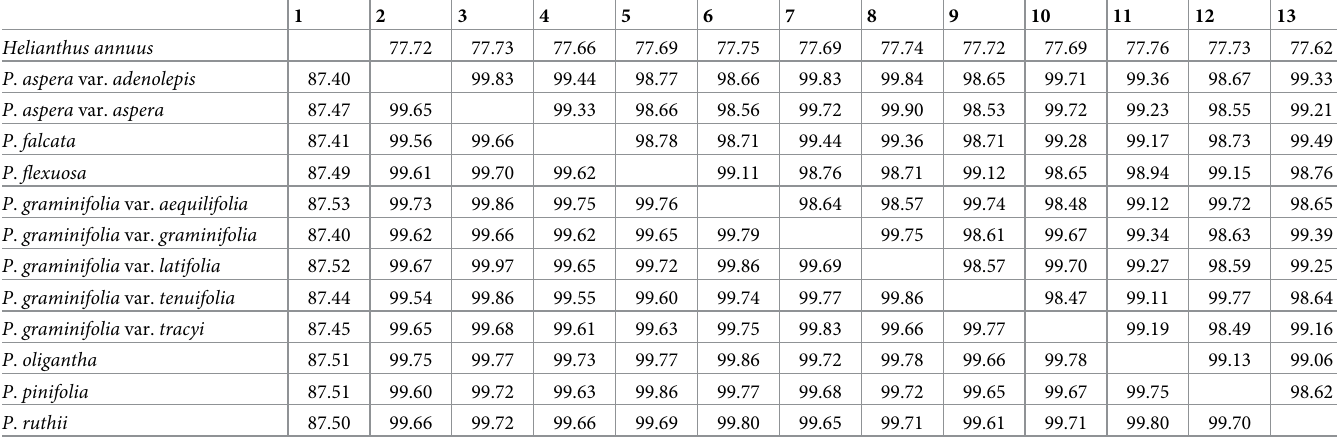
We reconstructed two maximum likelihood (ML) phylogenies, one with cp genomes (Fig 2) and one using the nuclear ribosomal repeat region (Fig 3). Only branches with 50% bootstrap (BS) support or higher were included in the topology. The cp genome and nuclear ribosomal region ML phylogenies differ primarily in the placement of some varieties of P . graminifolia and the two varieties of P . aspera . A close relationship between P . pinifolia and P . flexuosa was supported in both phylogenies, with the chloroplast tree showing the two as sister species (BS > 98). A similar relationship between P . graminifolia var. aequilifolia and var. tenuifolia Table 3. Pairwise alignment comparison of 12 Pityopsis species and varieties. Below diagonal is pairwise percent identity between chloroplast genomes calculated from a Mauve multiple sequence alignment. Above diagonal is pairwise percent identity between the short nuclear ribosomal region of the same species, calculated from a MUS- CLE multiple sequence